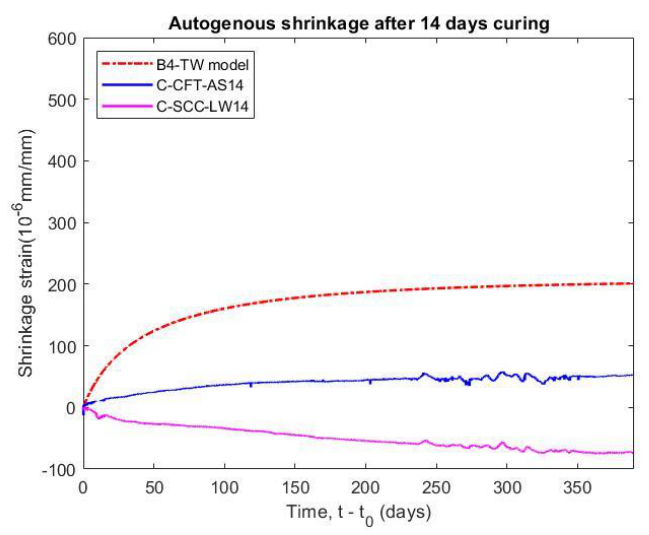
Figure 14. Comparison of experimental results and prediction model B4-TW for autogenous shrinkage measured at 14 days.